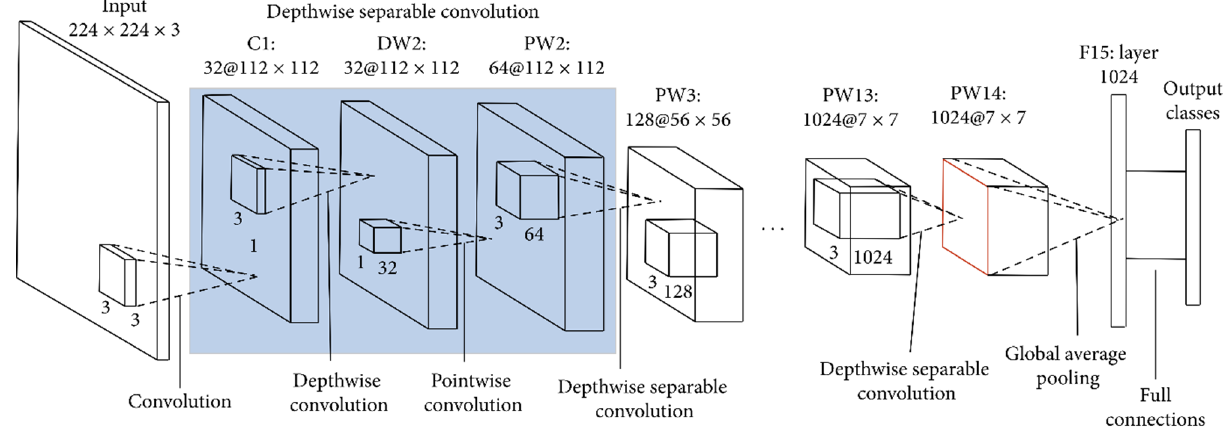
Figure 5. MobileNet architecture.